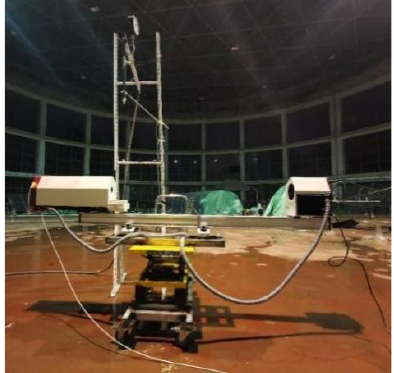
Figure 3. Spraying pesticide experiment system diagram